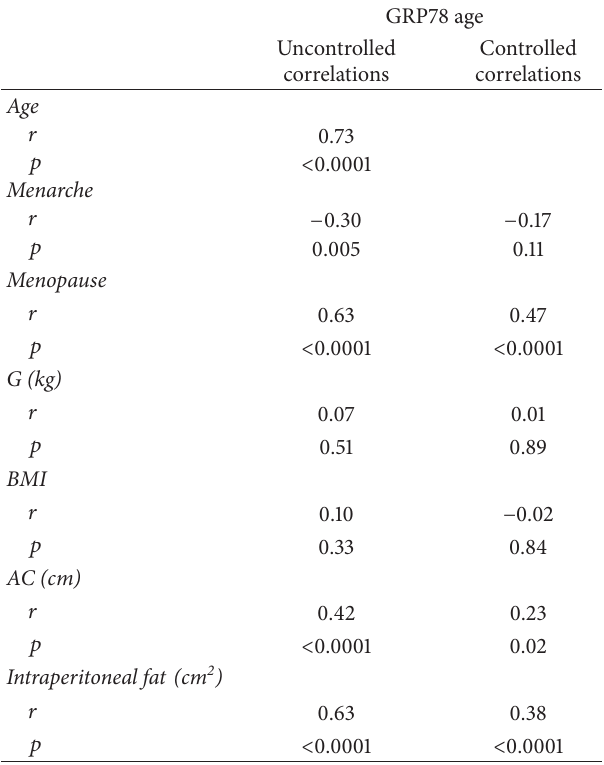
Table 2: Correlations between GRP78 and patient characteristics.